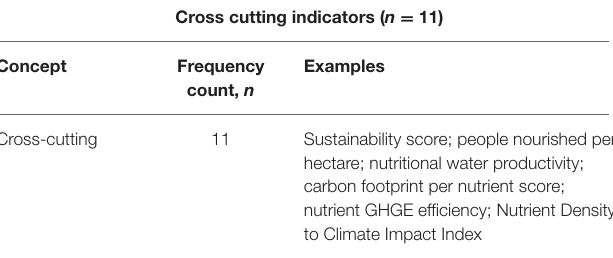
TABLE 4 | Cross-cutting indicators measured and frequency of use in the scoping